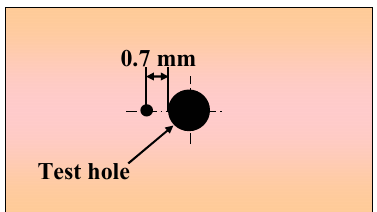
Figure 3 Predrilled thermocouple